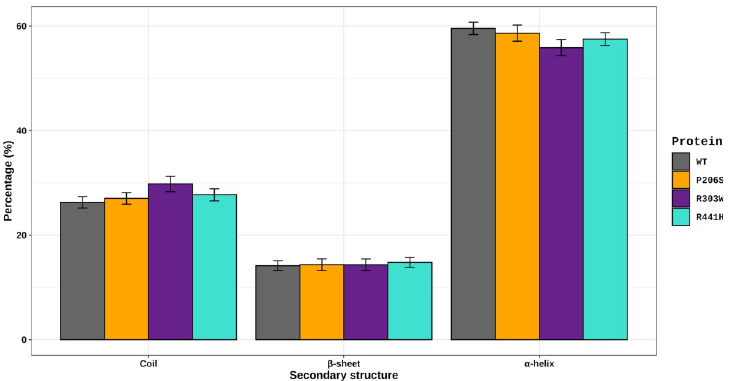
Fig 10. Secondary structure analysis of TPH2 WT and its variants. The average number (in percentages) of alpha- helices, beta-sheets and coils formed throughout the simulations of WT TPH2 and its variants P206S, R303W, and R441H are shown as a bar plot. The error bar represents the standard deviation. The bar plot was designed using the ggplot2 library implemented in R